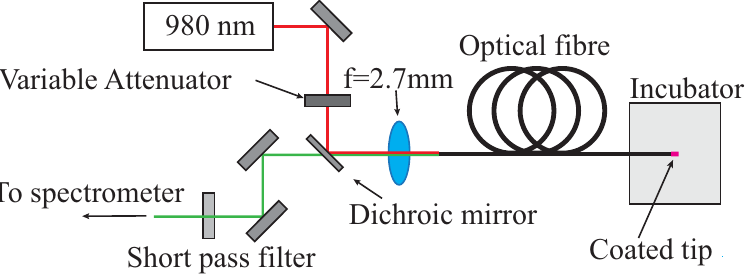
Figure 3. Experimental configuration for fibre optic temperature